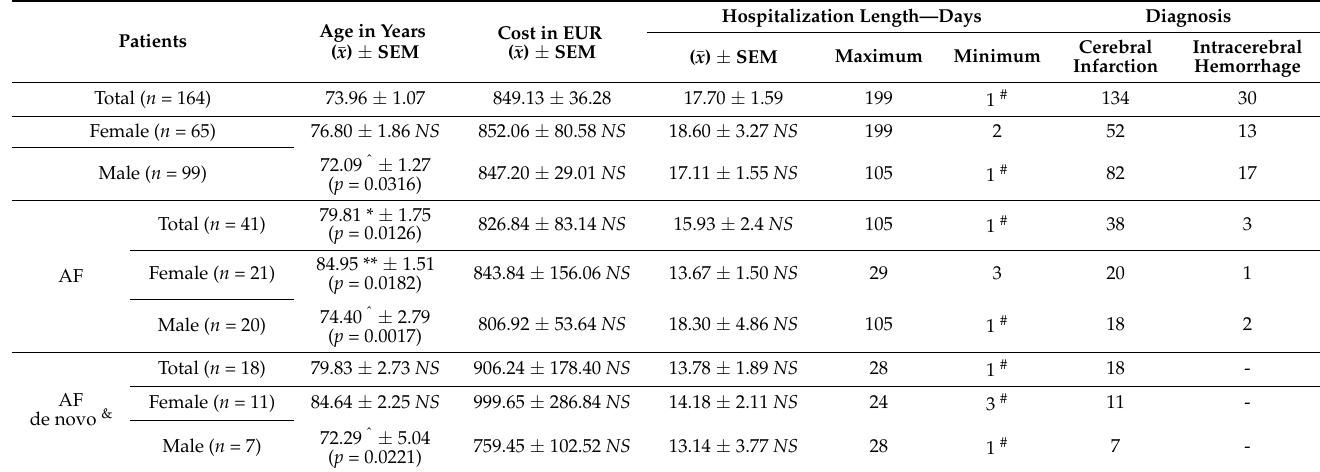
Table 1. The structure of the study group and related